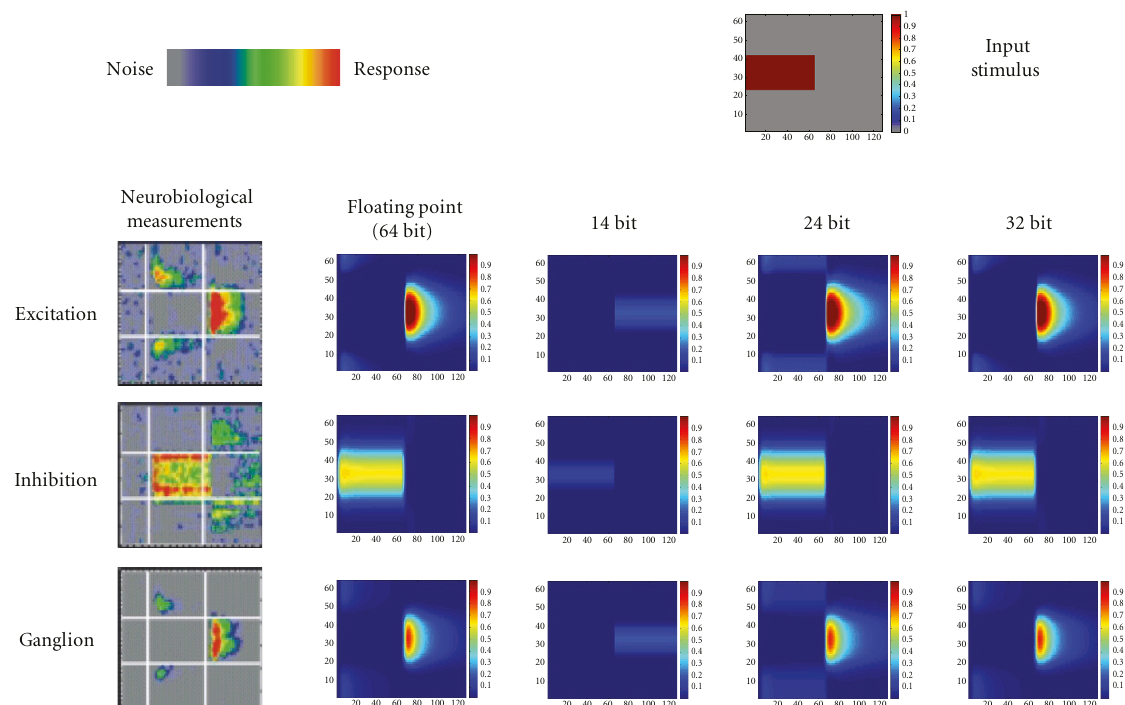
Figure 13: Accuracy of our solution at di ff erent bit widths (in case of O ff Brisk-Linear channel type) compared to the results of neurobiological measurements derived from [5]. The simple test input is a commonly used flashed square stimulus. The time runs horizontally while space is on the vertical axes. The total examined time period is 2 seconds, where the flashing white stimulus is “turned-on” for 1